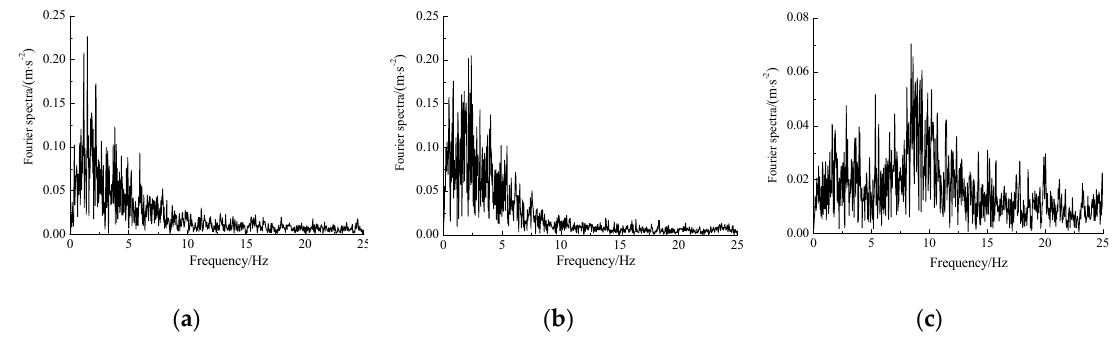
Figure 3. Fourier spectra of the El Centro ground motion: ( a ) X-direction; ( b ) Y-direction; ( c ) Z-direction. Appl. Sci. 2020 , 10 , x FOR PEER REVIEW as Figure 4.